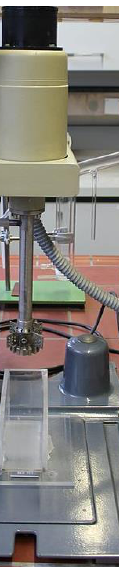
Table 2. Variables for the full factorial design. “1” corresponds to a high factor level; “ − 1“refers to a low factor level; “0” refers to a center